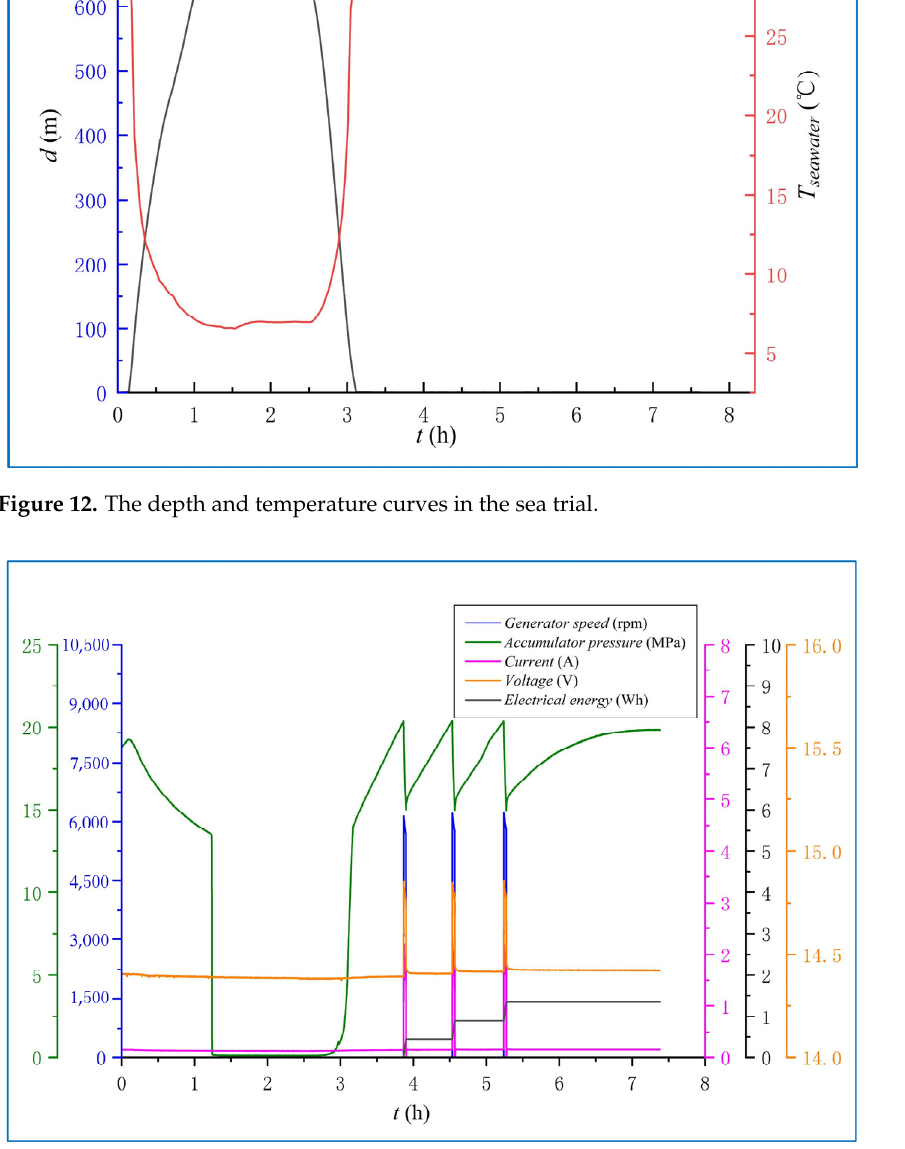
Figure 13. Power generation performance of thermal energy power generation module during the sea trial.